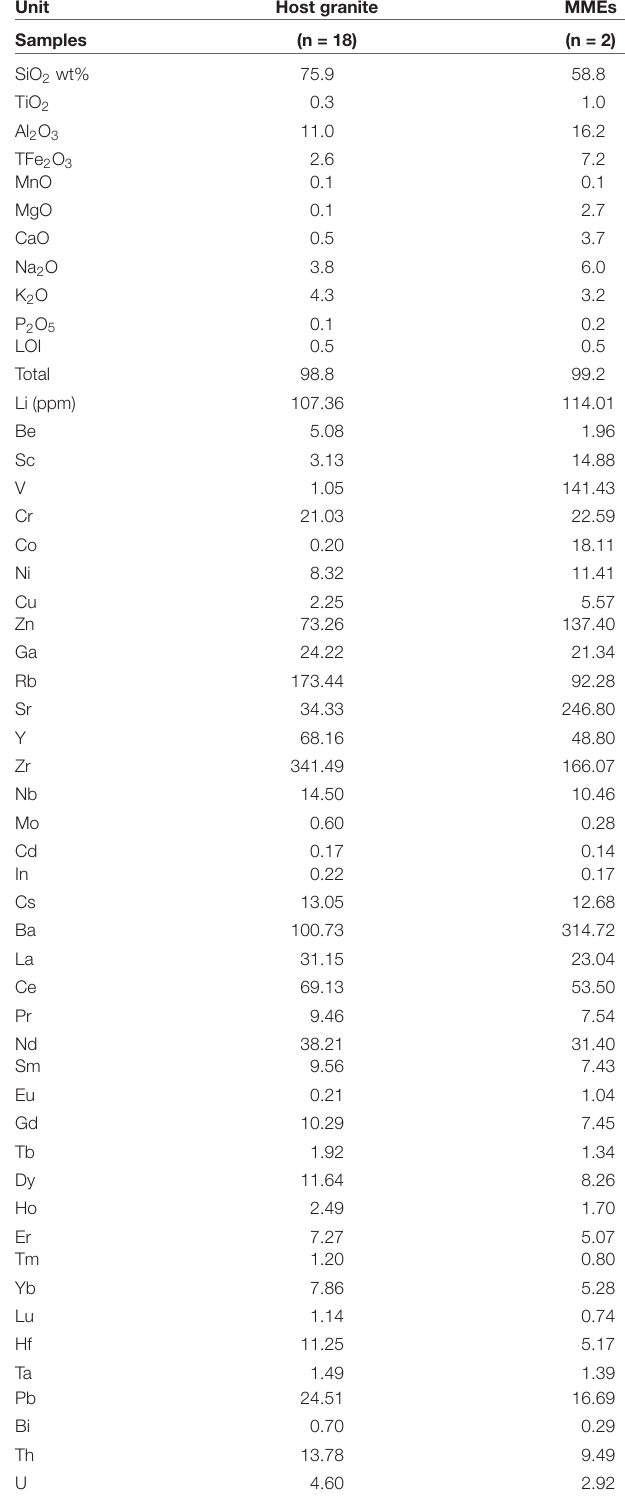
TABLE 3 | Average whole-rock major and trace element contents of the host granite and